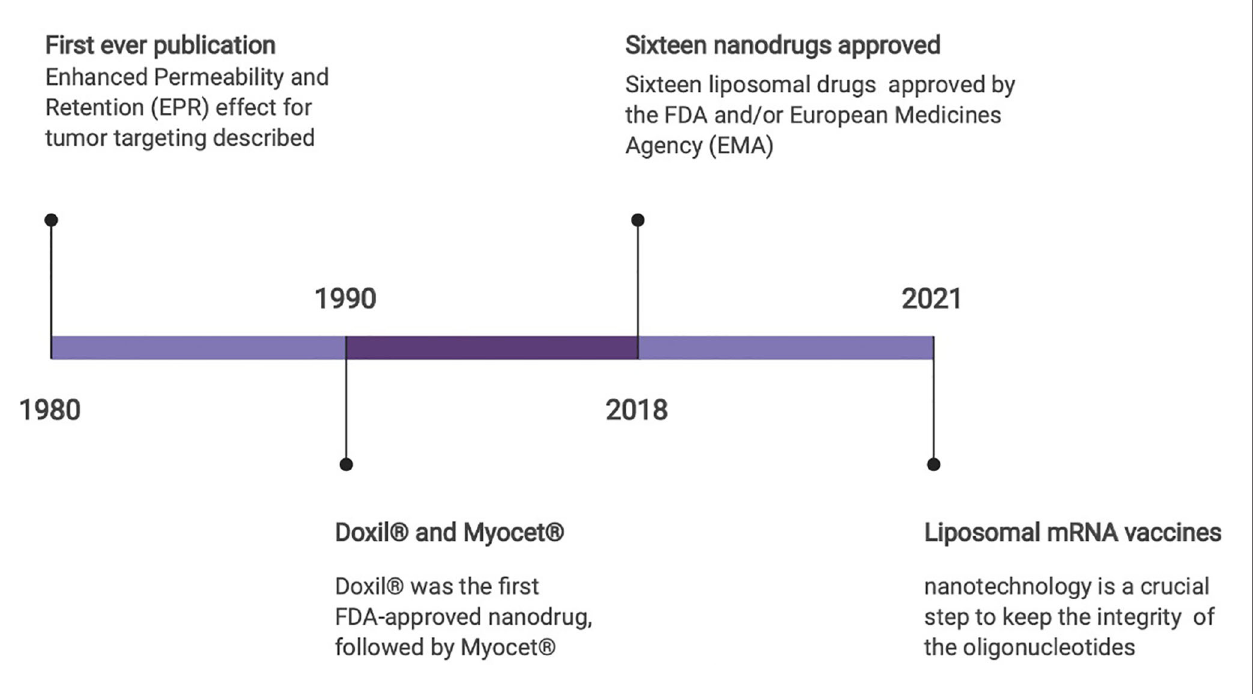
FIGURE 1 | Nanomedicine